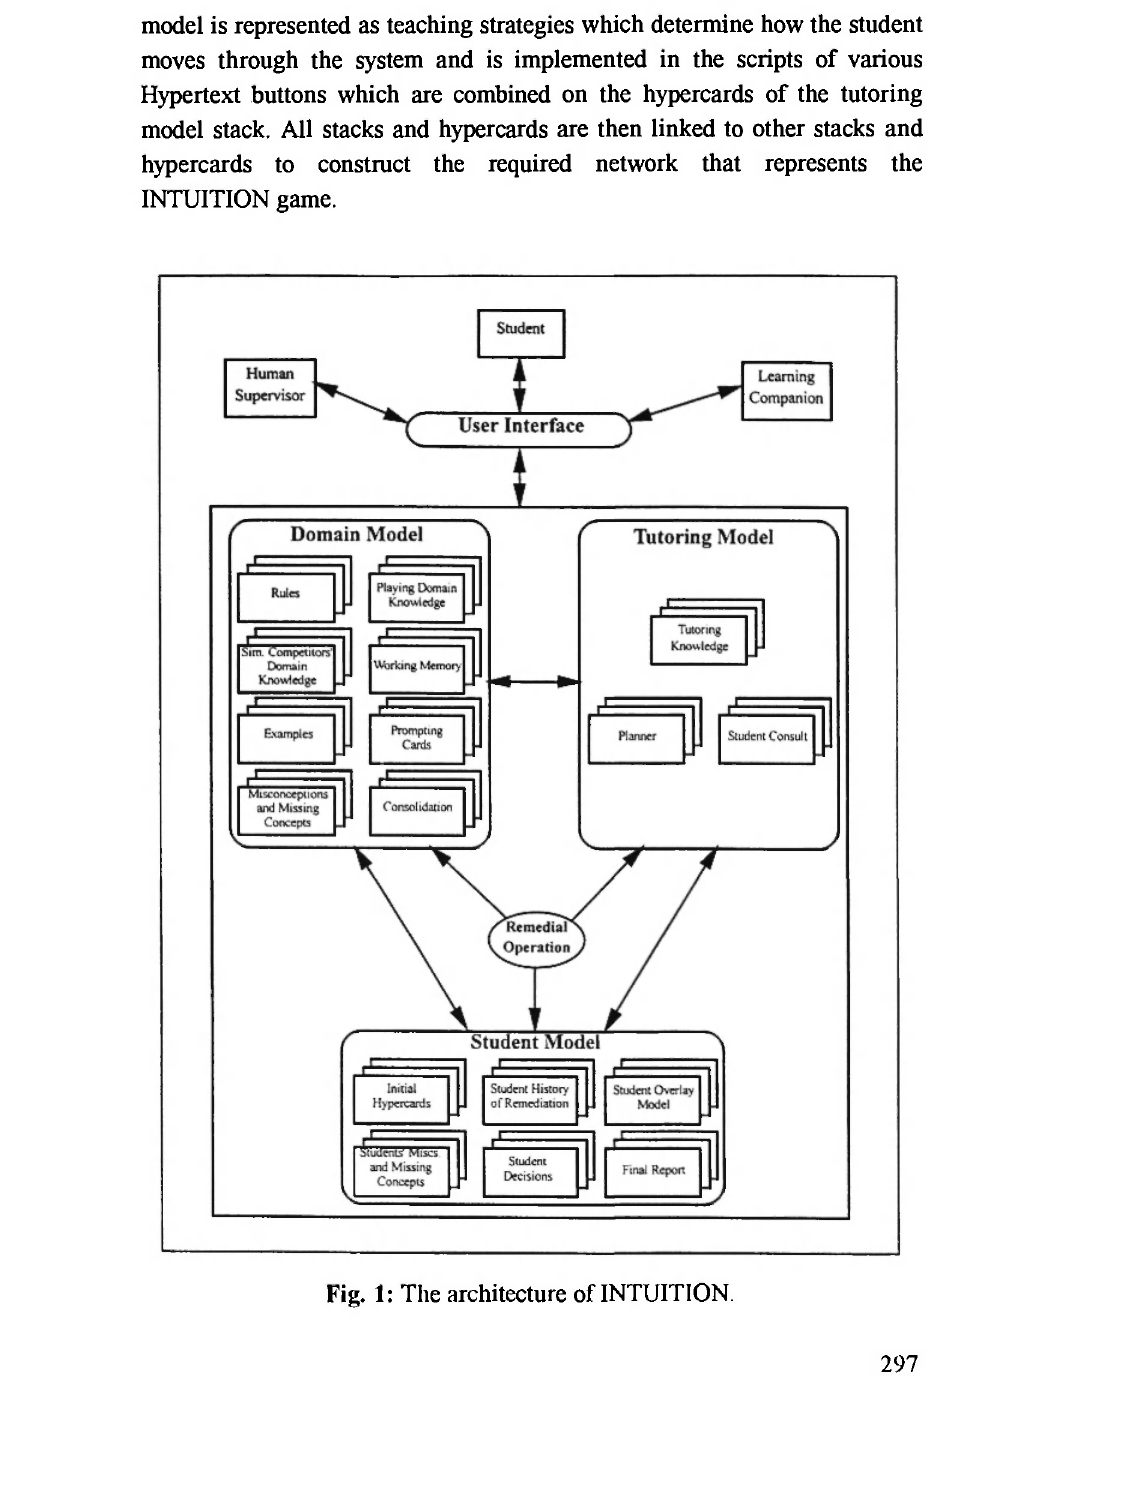
Fig. 1: The architecture of